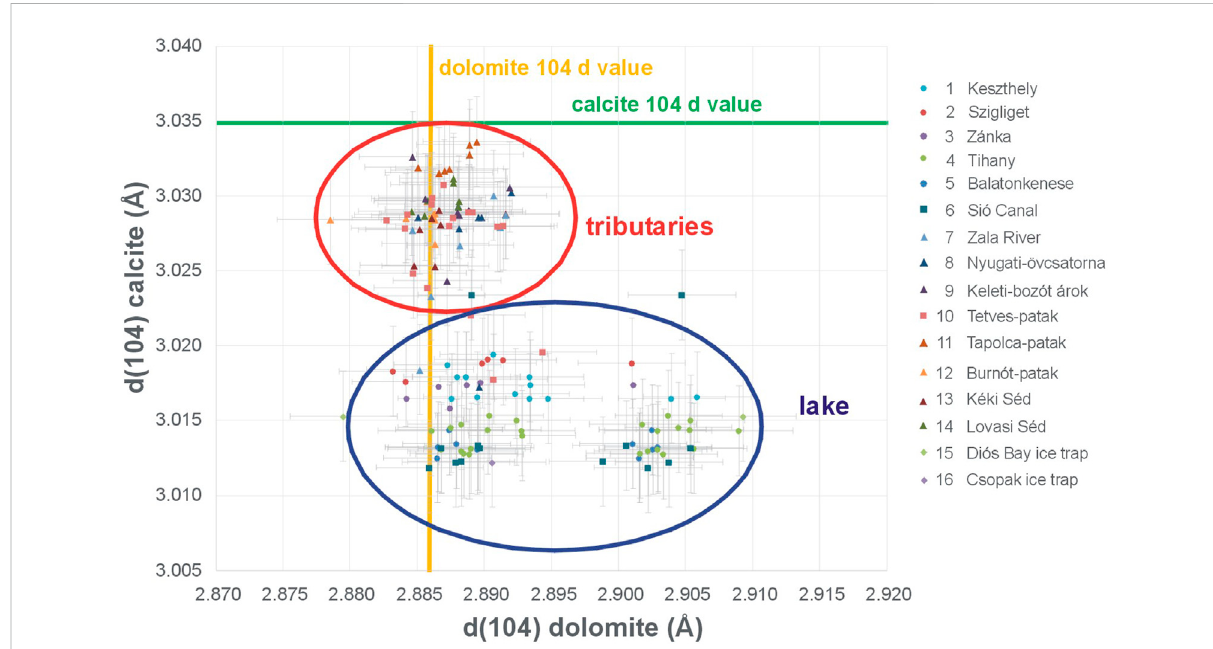
FIGURE 7 Calcite and dolomite d ( − 104)-values measured on XRD patterns obtained from suspended particles collected from tributaries, Lake Balaton, andtheSióCanal.Eachdatapointrepresentsasample,exceptforsomesamplesfromtheEasternBasinofthelake,forwhichthedolomite − 104peak was split and thus two data points correspond to each sample (error bars: ± 0.003 Å). The d ( − 104) values of stoichiometric calcite and dolomite are represented by the horizontal green and the vertical yellow lines,